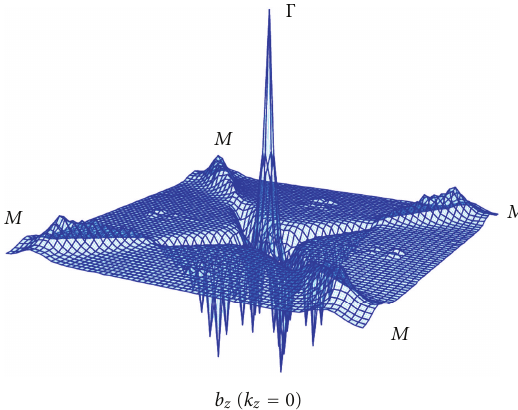
Figure 3: Calculated gauge field strength for t 2g bands in SrRuO 3 as a function of ( k x , k y ) with fixed k z = 0. The sharp peak at k x = k y = 0 represents a magnetic monopole at the Fermi surface which strongly a ff ects σ xy . The figure is taken from